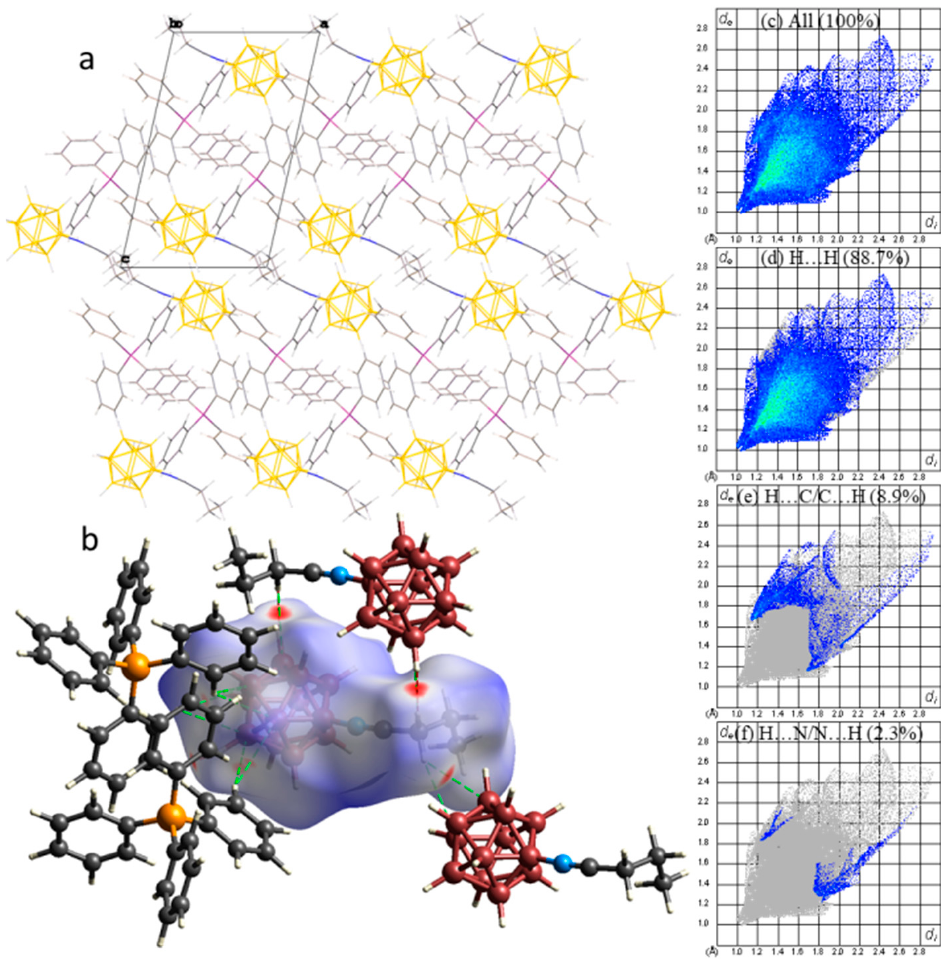
Figure 3. ( a ) Packing diagram, ( b ) d norm surface of ((C 6 H 5 ) 4 P)[B 12 H 11 NC n -C 3 H 7 ] − anion for compound 2 , ( с ) full two-dimensional fingerprint plot for 2 , together with that delineated into ( d ) H...H, ( e ) H...C/C...H, and ( f ) H...N/N...H contacts.